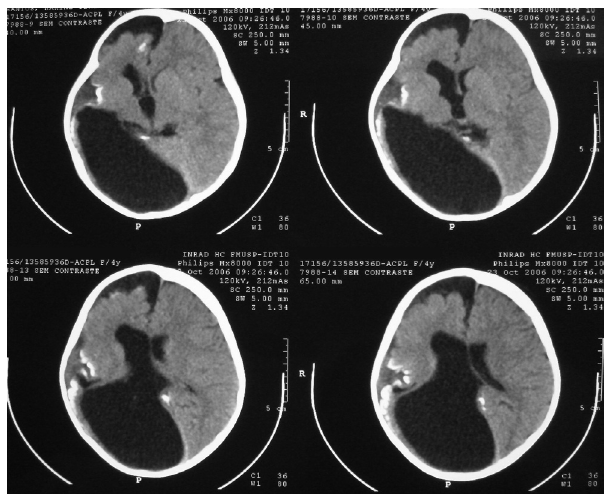
Figure 5 - Post-operative results Figure 3 - CT scan of the brain shows: porencephalic cyst, hemiatrophy of